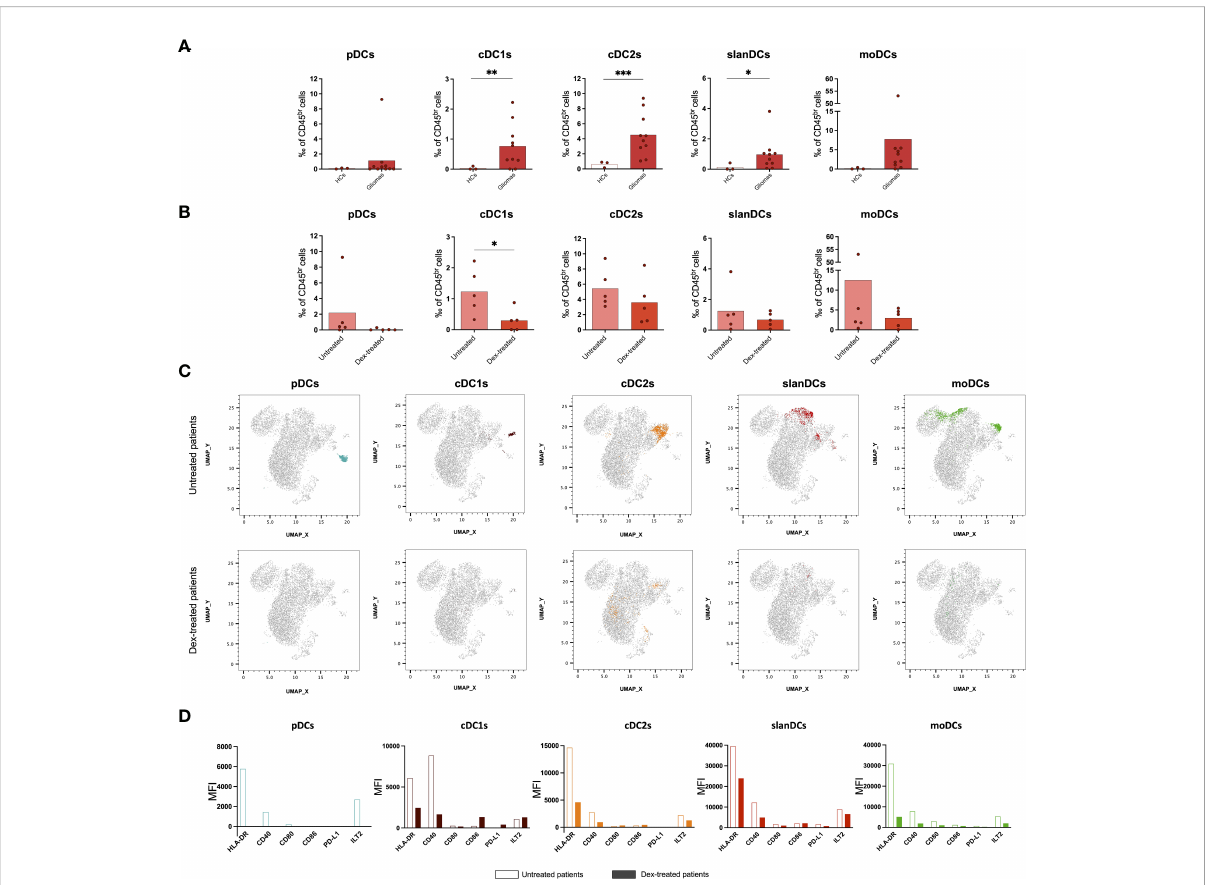
FIGURE 2 Flow cytometric analysis of TIDC subsets showing that perioperative corticosteroid treatment inhibits intratumoral DC recruitment and activation. (A) Frequency of DC subsets in healthy tissues (heathy controls: HCs, n=3) and tumor tissues (Gliomas, n=10) obtained from glioma patients. (B) Frequency of TIDC subsets in glioma patients either untreated (Untreated, n=5) or treated with dexamethasone (Dex-treated, n=5). Data expressed as per-thousand ( ‰ ) of CD45 br cells. Each symbol represents a single sample. In each series, the mean is shown. *p<0.05, **p<0.01, ***p<0.001, calculated using the t-test. (C) UMAP plots showing the clustering of TIDC subsets in untreated and dex-treated glioma patients. Each plot shows a single DC subset as identi fi ed with manual gating strategy. Viable tumor-in fi ltrating CD45 br /lin − /HLA-DR + cells of down-sampled, concatenated fi les obtained from all glioma patients are shown in gray. pDCs are highlighted in dark turquoise, cDC1s in brown, cDC2s in orange, slanDCs in red, and moDCs in green. (D) Expression of HLA-DR, activatory molecules (CD40, CD80, CD86), and inhibitory molecules (PD-L1, ILT2) on each DC subset, expressed as MFI measured on concatenated fi les, and compared between untreated and dex- treated glioma